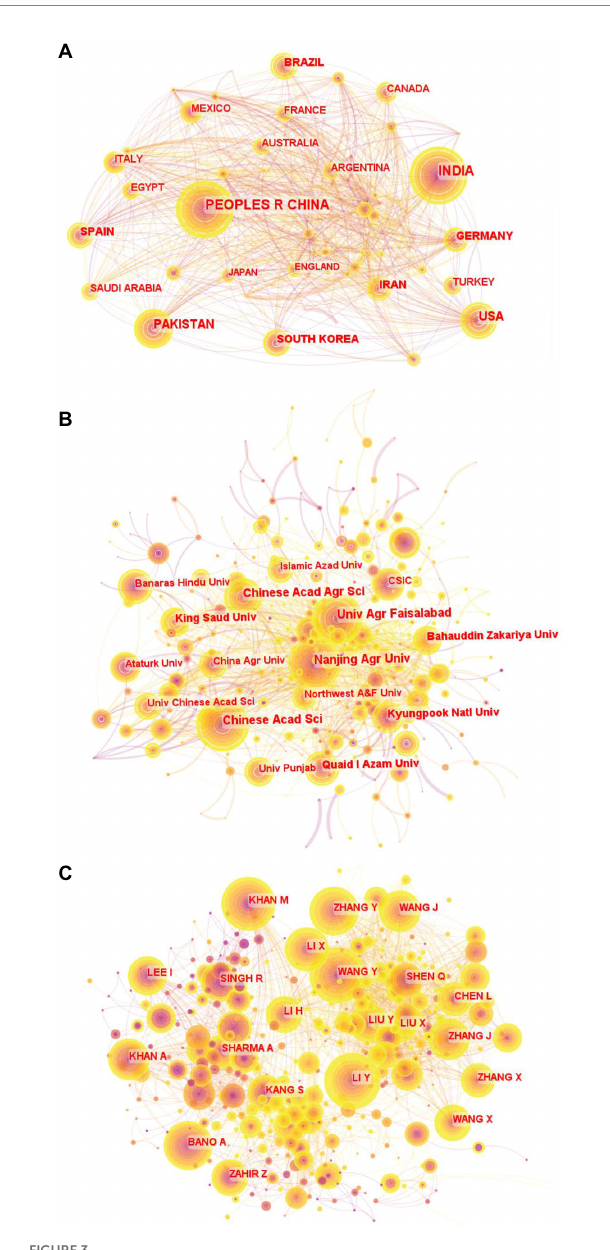
FIGURE 3 Cooperation network of major countries/regions engaged in rhizosphere microorganisms research (A) . Cooperative network of major institutions engaged in rhizosphere microorganisms research (B) . Cooperative network of leading authors engaged in rhizosphere microorganisms research (C) .